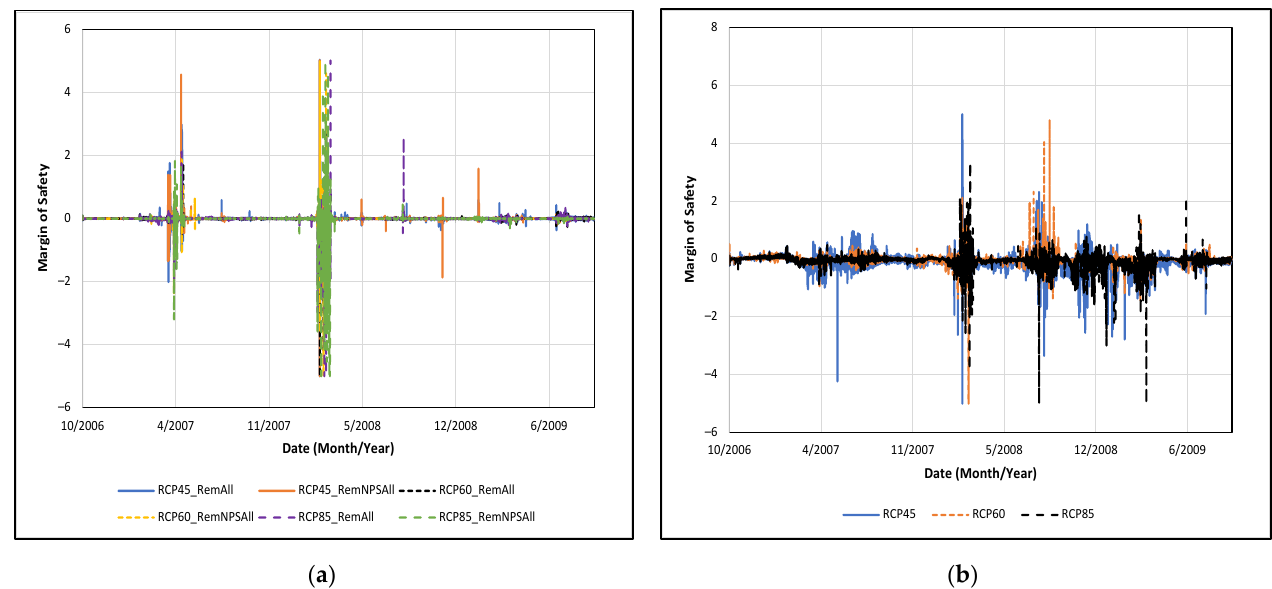
Figure 4. Suggested Margins of Safety for Theoretical WQT Buyer TN over the Jordan River Simulation (1 October 2006 to 30 September 2009) with Population Characteristics only under Distinct RCP Projections (RCP45 = RCP 4.5; RCP60 = RCP 6.0; RCP85 = RCP 8.5) for Inflow Increase by 1.15 for ( a ) the Delivery and ( b ) Downstream Trade Ratio Components.